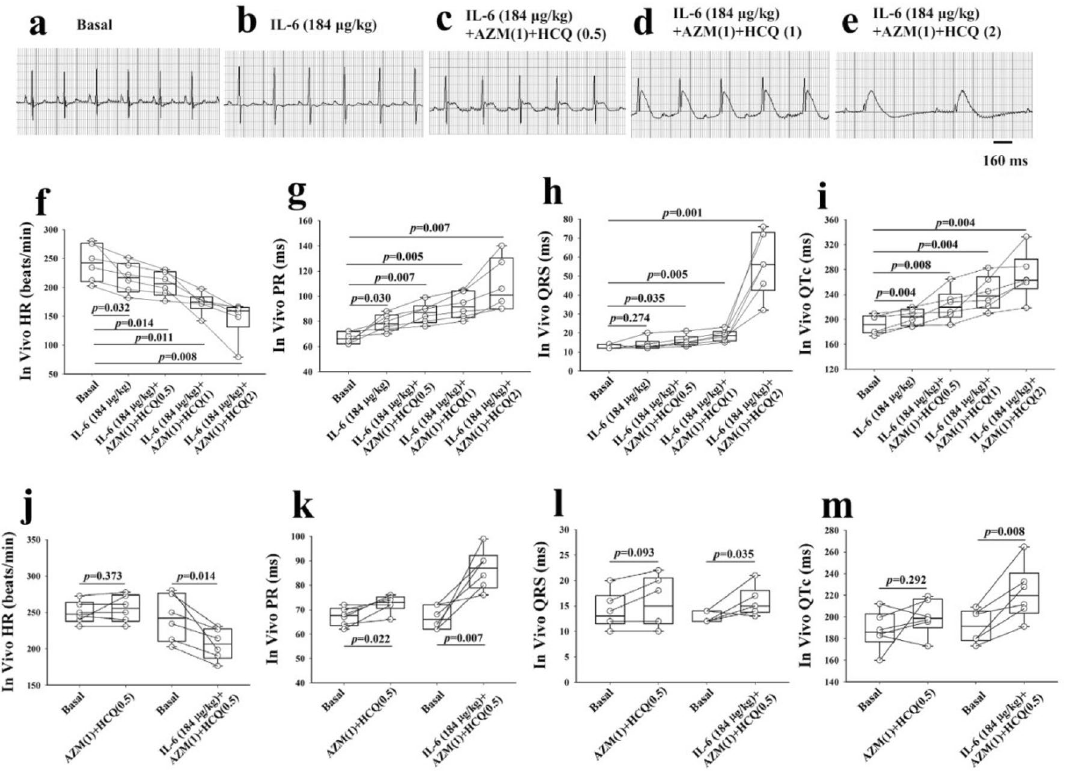
Figure 1. In-vivo impact of interleukin-6, azithromycin and hydroxychloroquine on the electrocardiogram of guinea pigs. ( a ) ECG of a guinea pig before, ( b ) after administration of IL-6(184 μg/kg) alone, ( c ) IL-6 + AZM(1) + HCQ(0.5), ( d ) IL-6 + AZM(1) + HC(1) and ( e ) IL-6 + AZM (1) + HCQ(2). Comparison of individual data points for heart rate (HR), PR, QRS and QTc between baseline and different interventions is illustrated in panels ( f–i) using paired t -test versus basal group and one-way repeated measures analysis of variance for multiple comparisons among the drug interventions. Heart rate ( j ), PR ( k ), QRS ( l ) and QTc ( m ) data from two groups of guinea pigs, one (n = 6) injected with AZM (1) and HCQ (0.5) and the other (n = 6) injected with IL-6 (184 μg/kg) + AZM (1) + HCQ (0.5). AZM (1) = 38.2 mg/kg; HCQ(0.5) = 22.9 mg/kg; HCQ(1) = 45.8 mg/kg; HCQ(2) = 91.6 mg/kg. p values shown are in comparison to basal